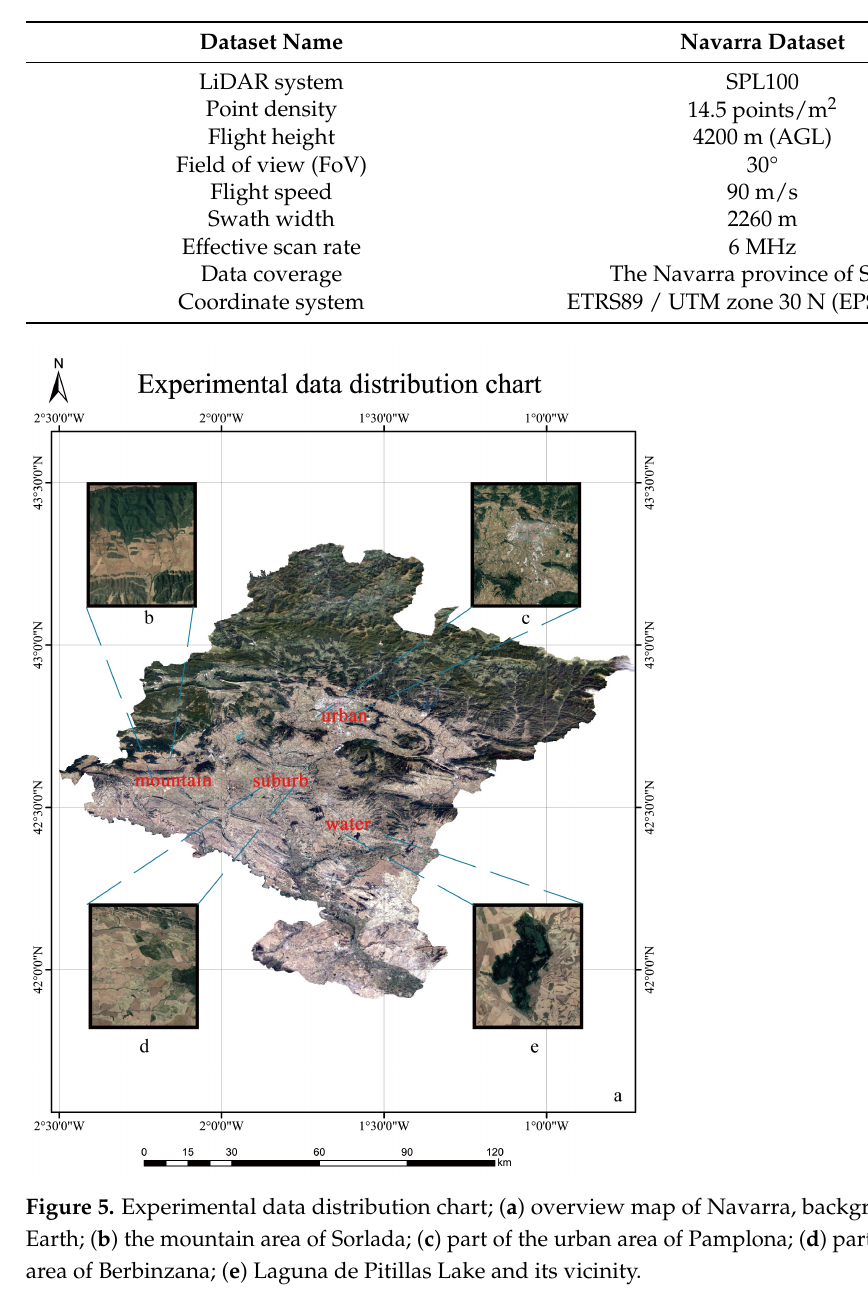
Table 1. Dataset information.